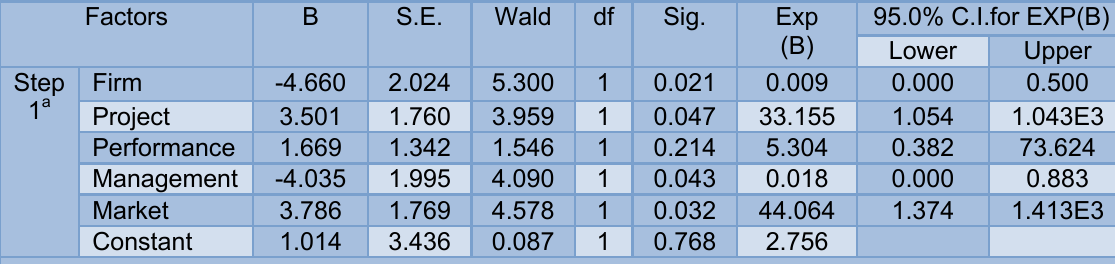
Table 11: Variables in the Equation for ET Decision